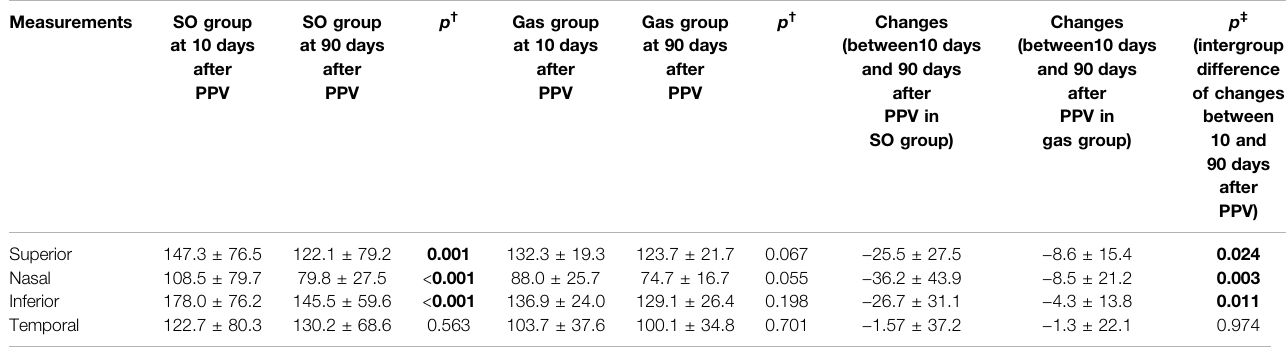
TABLE 5 | Intergroup differences in longitudinal changes in peripapillary retinal nerve fi ber layer thickness in each sector a .